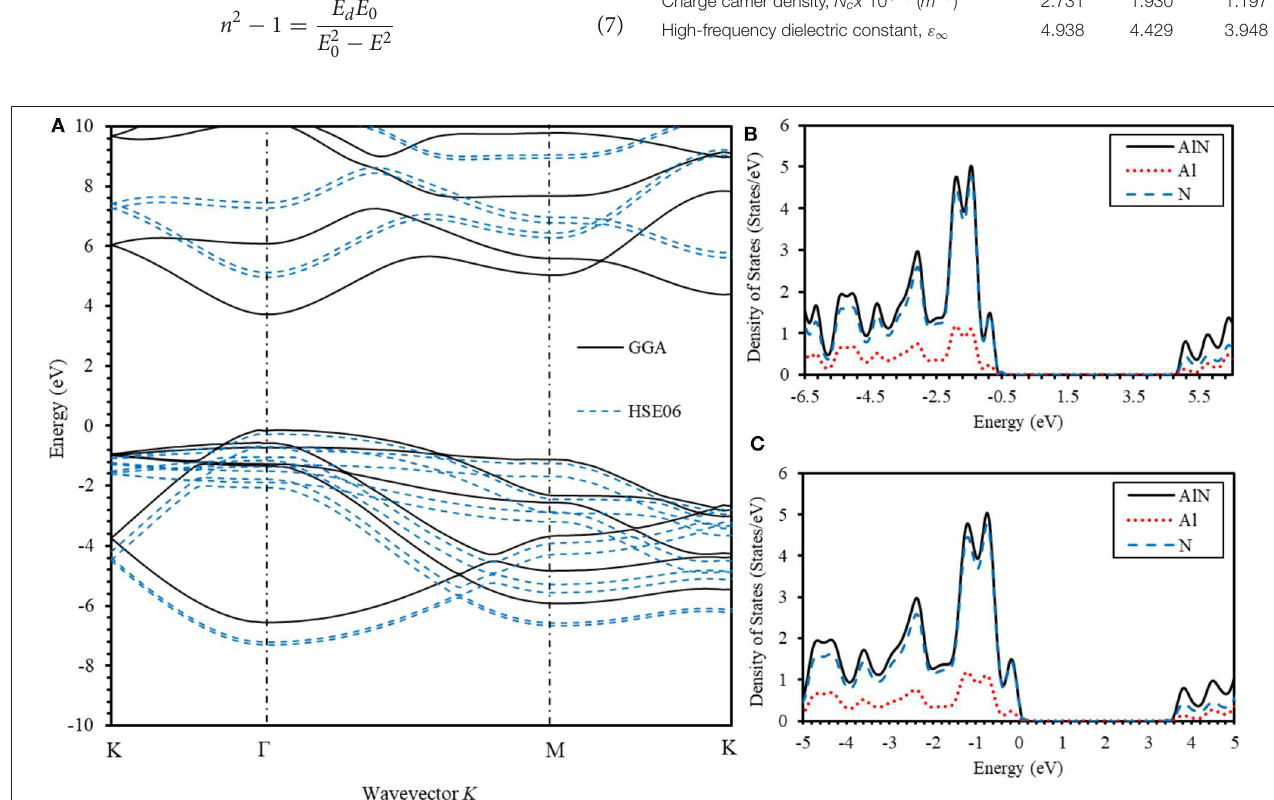
FIGURE 7 | (A) The calculated electronic band structure of aluminum nitride (AlN) system using GGA and HSE06 methods. (B) Total DOS and PDOS of AlN, Al, and N atoms using GGA method and (C) total DOS and PDOS of AlN, Al, and N atoms using HSE06 method.